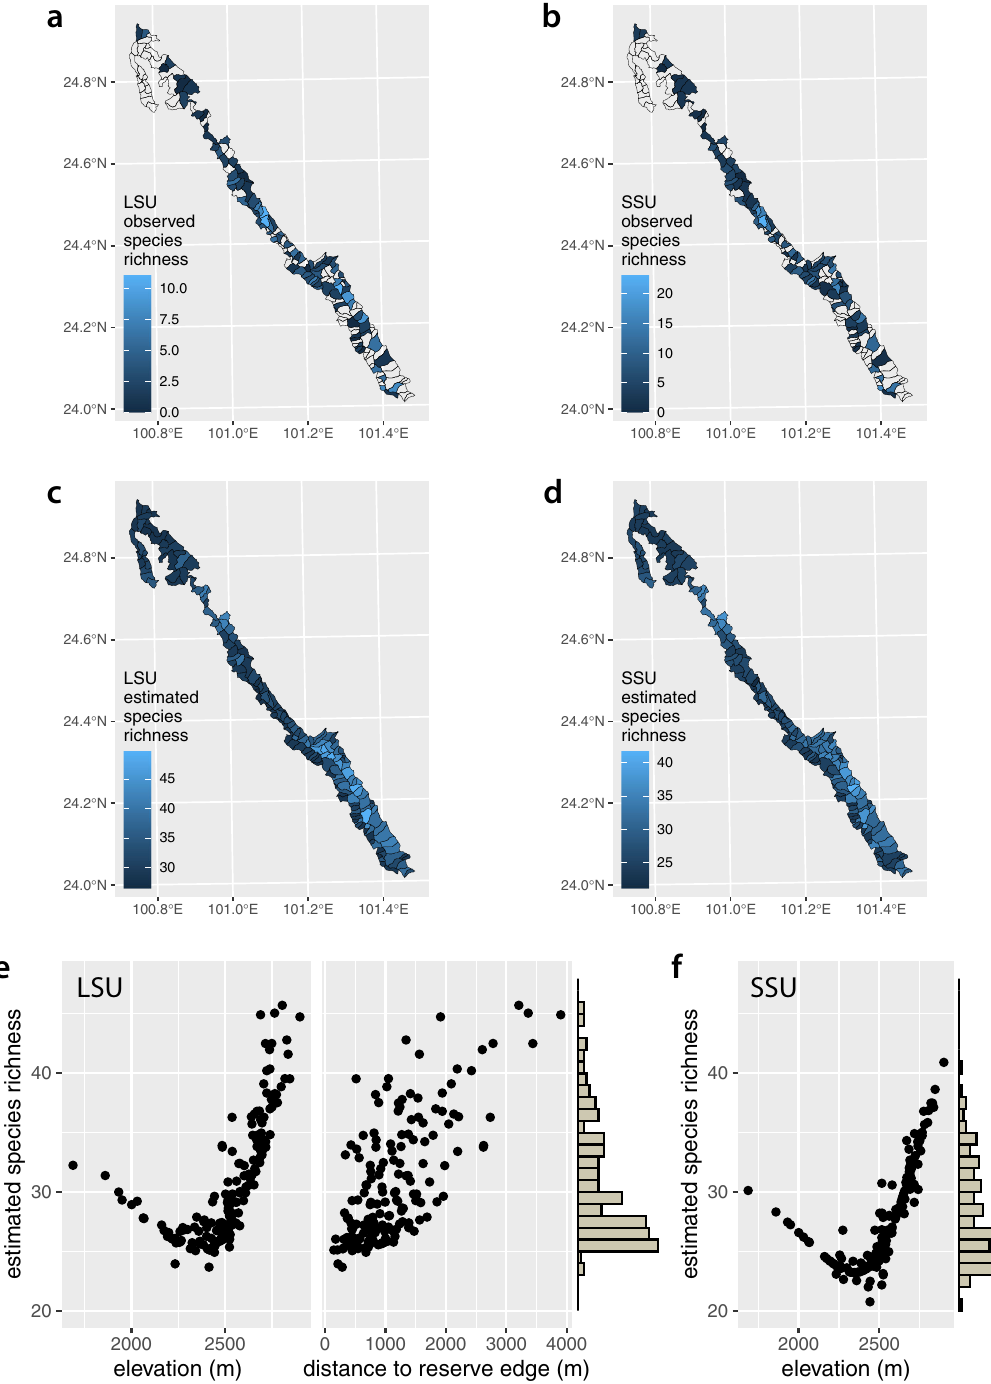
Fig. 3 Species richness by patrol area. a , b Observed species richness in each patrol area in the LSU and SSU datasets respectively. Note missing data (no shading) in approximately half of the patrol areas. Data with missing patrol area IDs are not represented in this fi gure, though they are incorporated in our occupancy model. c , d Estimated species richness for each patrol area in the LSU and SSU datasets respectively. Note that our occupancy model provides estimates for patrol areas with missing data, in addition to augmenting observed values to account for false negatives. e , f Scatterplots of estimated species richness against environmental covariates in the LSU and SSU models respectively. Histograms along the y -axes show the distribution of species richness estimates across the patrol